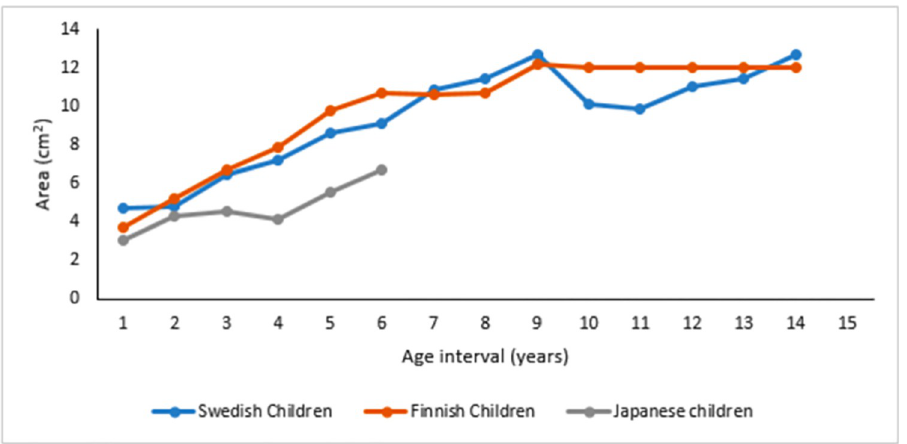
Fig 3. Line graph showing growth rate and size of mastoid air cell systems of studies that utilized 1 year age grouping. X-axis displays age in years, and Y-.axis illustrates the size of the mastoid air